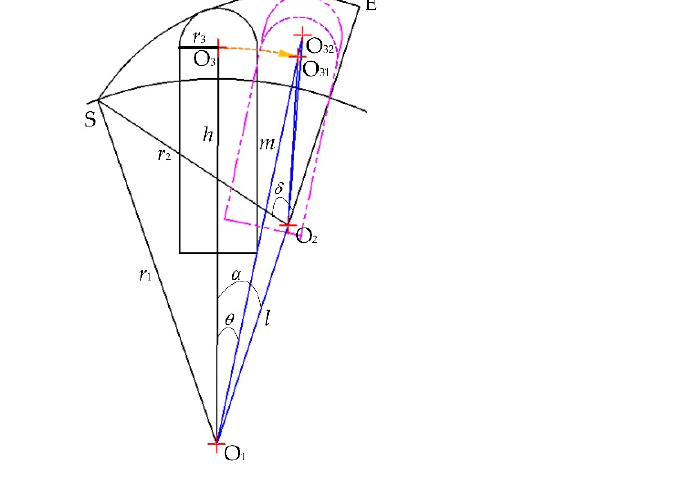
Figure 9. The kinematic analysis of the unlocking process of the low-power holding mechanism.